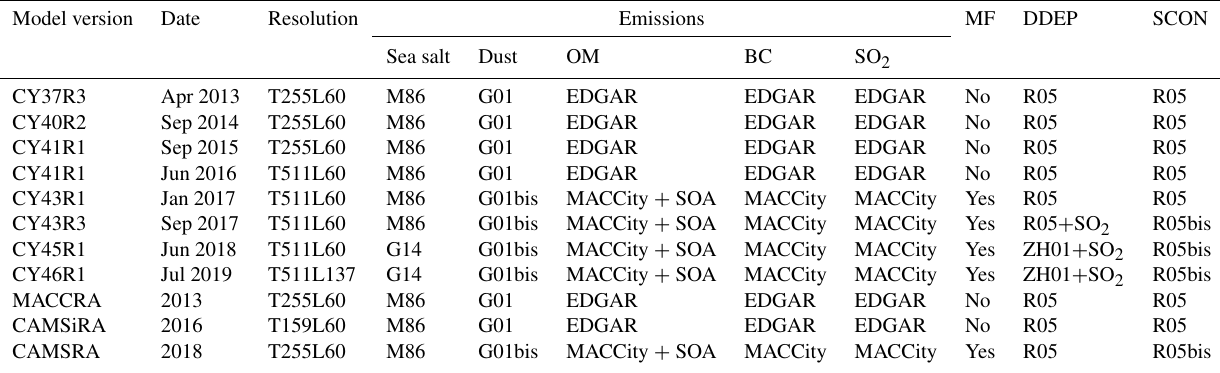
Table 3. IFS-AER cycles and options used operationally for near-real-time global CAMS products. MF stands for mass fixer, DDEP for dry deposition, and SCON for sulfate conversion. G01bis is for the Ginoux et al. (2001) dust emission scheme with a modified distribution of the emissions into the dust bins. R05bis is for the updated simple sulfate conversion scheme with temperature and relative humidity dependency. Cycle 46R1 also includes new developments not described in this article.